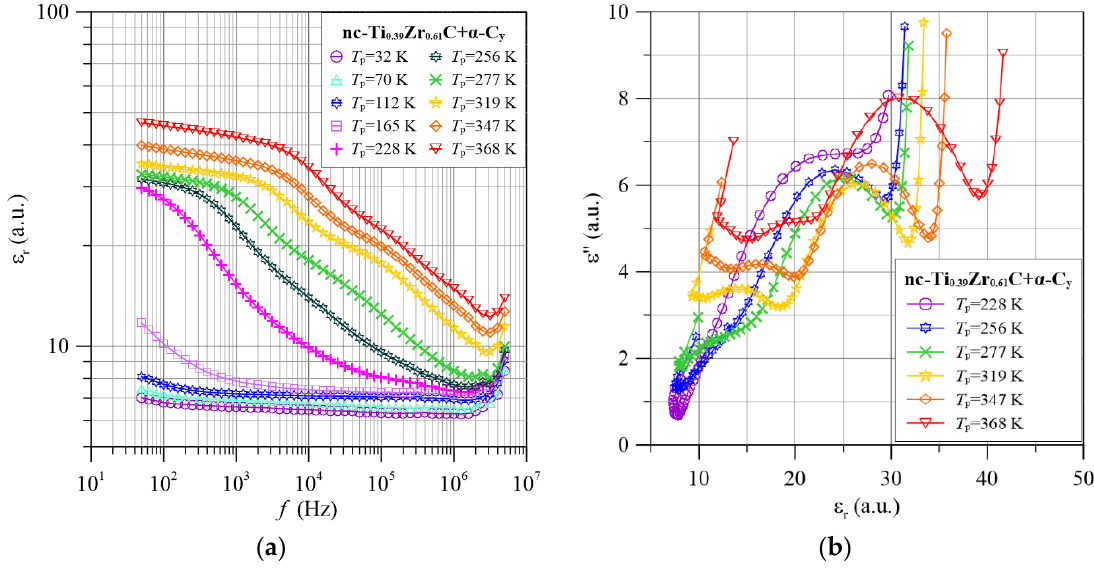
Figure 9. Frequency dependence of permittivity ( a ) and Cole-Cole diagrams ( b ) for selected measurement temperatures for the nc-Ti 0.86 Zr 0.14 C+ α -C y nanocomposite.